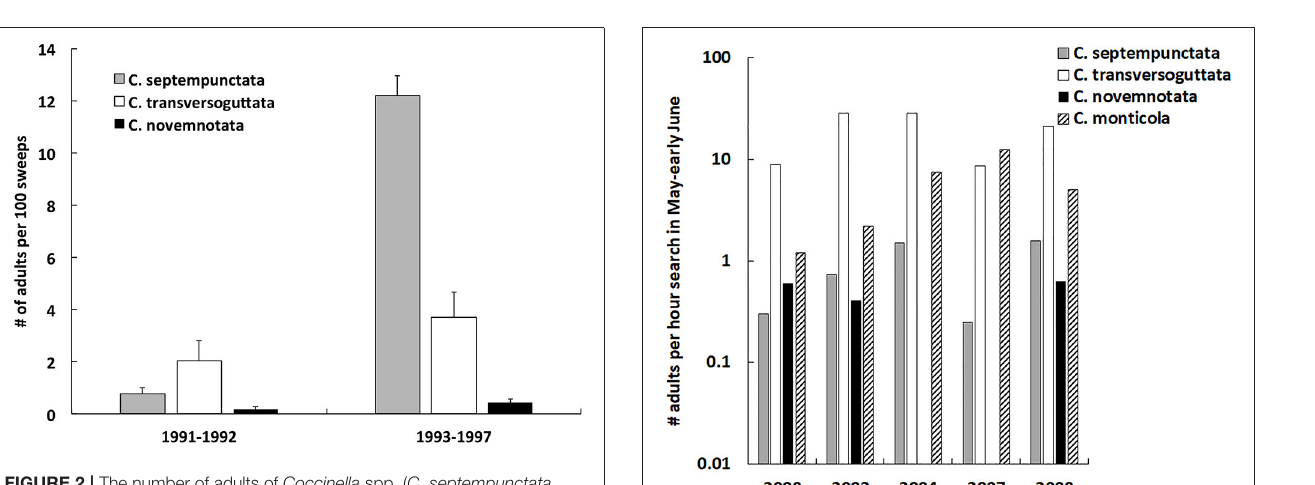
Coccinella species was consistent among all months over the 2 years, with C. novemnotata always accounting for < 1% of individuals in any given